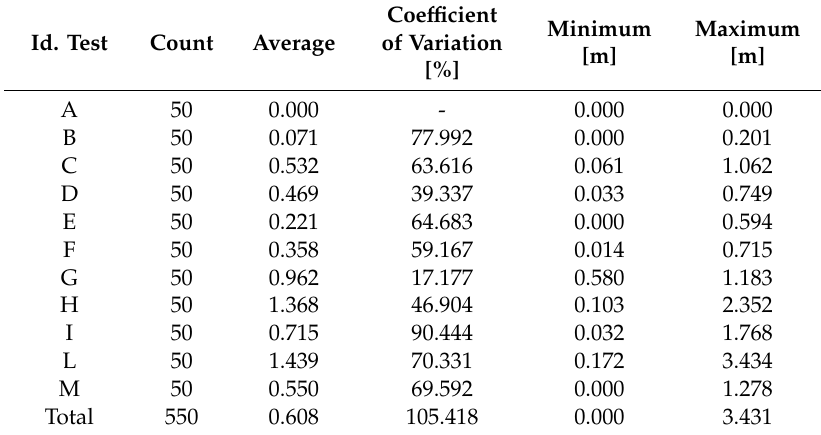
Table 2. Summary statistics for distance 1 .